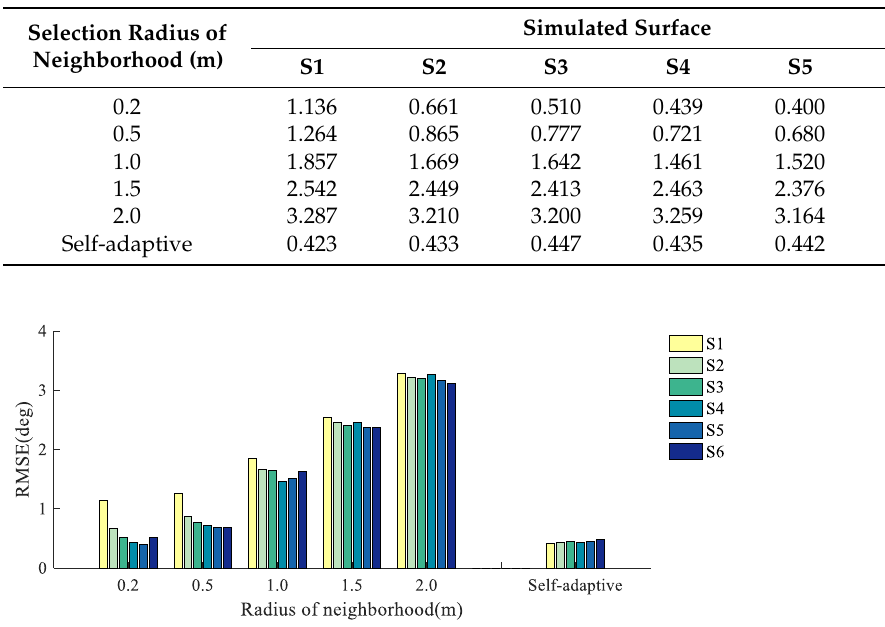
Figure 17. Accuracy of surface aspect estimation with different surface complexities and selection ranges of neighborhood points.